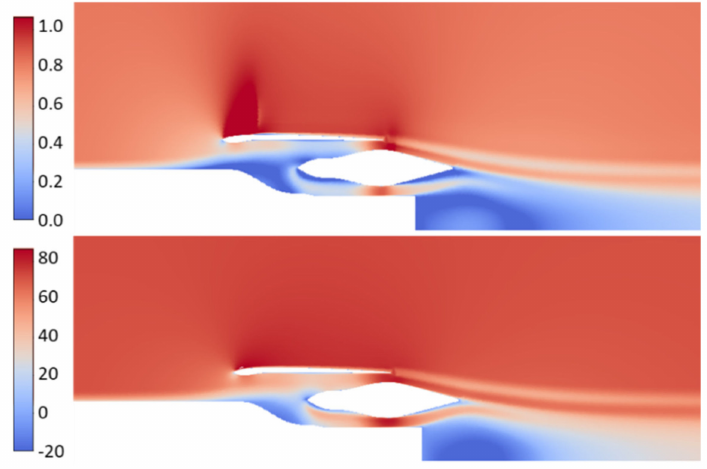
Figure 12. Contours of Mach number for cruise ( top ) and V x [m/s] for take-off ( bottom ). NOVA- similar design, 2D